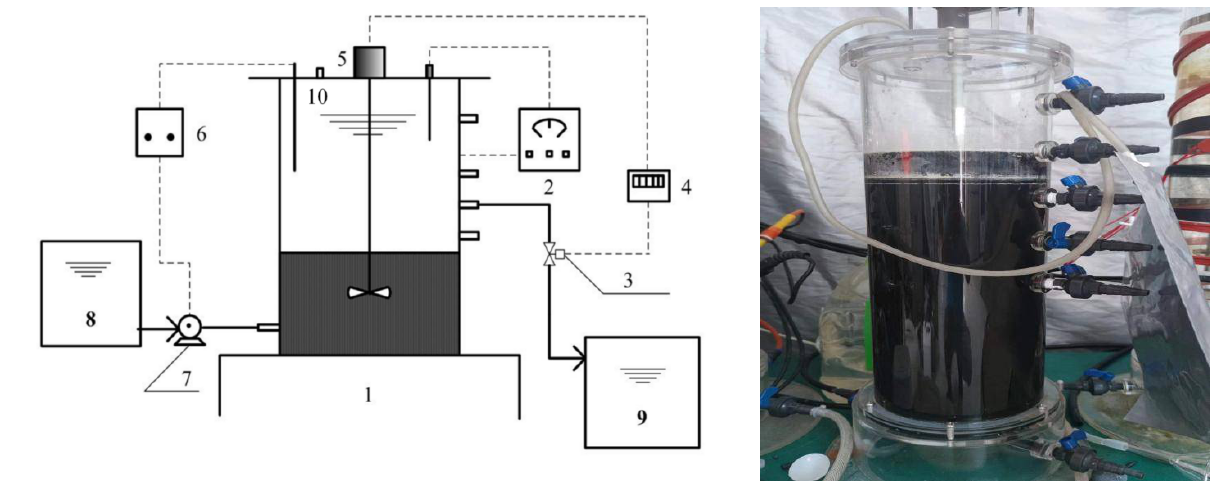
Figure 1. ASBR experimental device: 1: ASBR; 2: temperature controller; 3: solenoid valve; 4: time relay; 5: stirrer; 6: water-level meter; 7: peristaltic pump; 8: feeding tank; 9: effluent tank; 10: gas-sampling port.